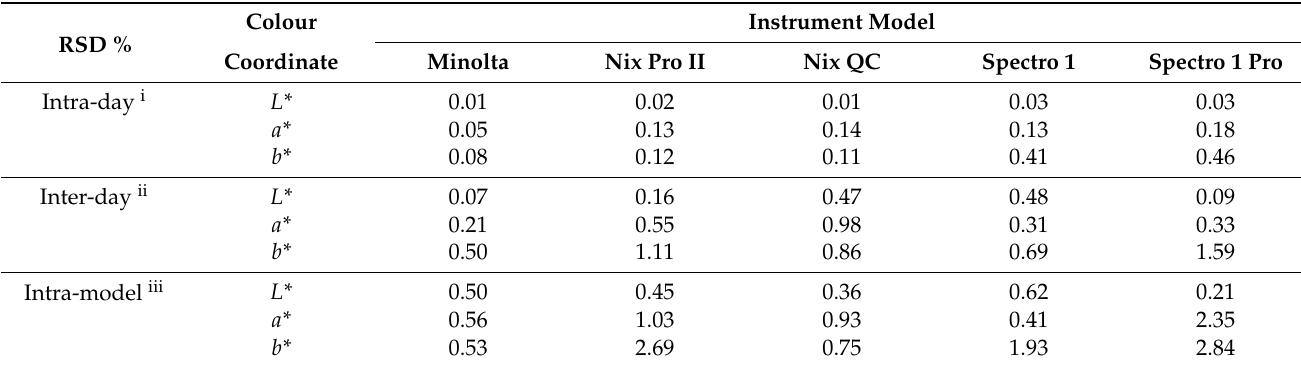
Table 2. Variability of instrument measurements of Canadian pork colour standards represented by average relative standard deviation (RSD %).